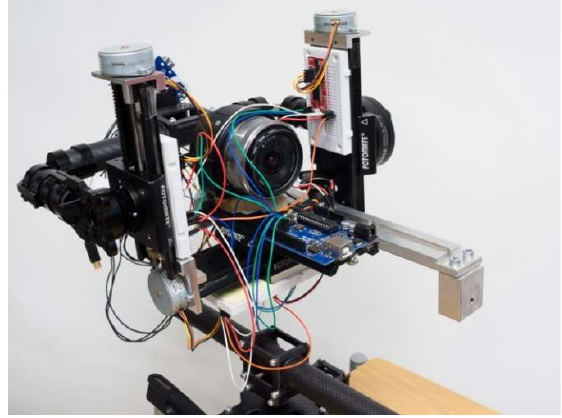
Figure 4. The motorized camera mount. Figure 5. The Arduino control circuit is operating the mount automatically. Smaller blue circuit board is the MPU6050